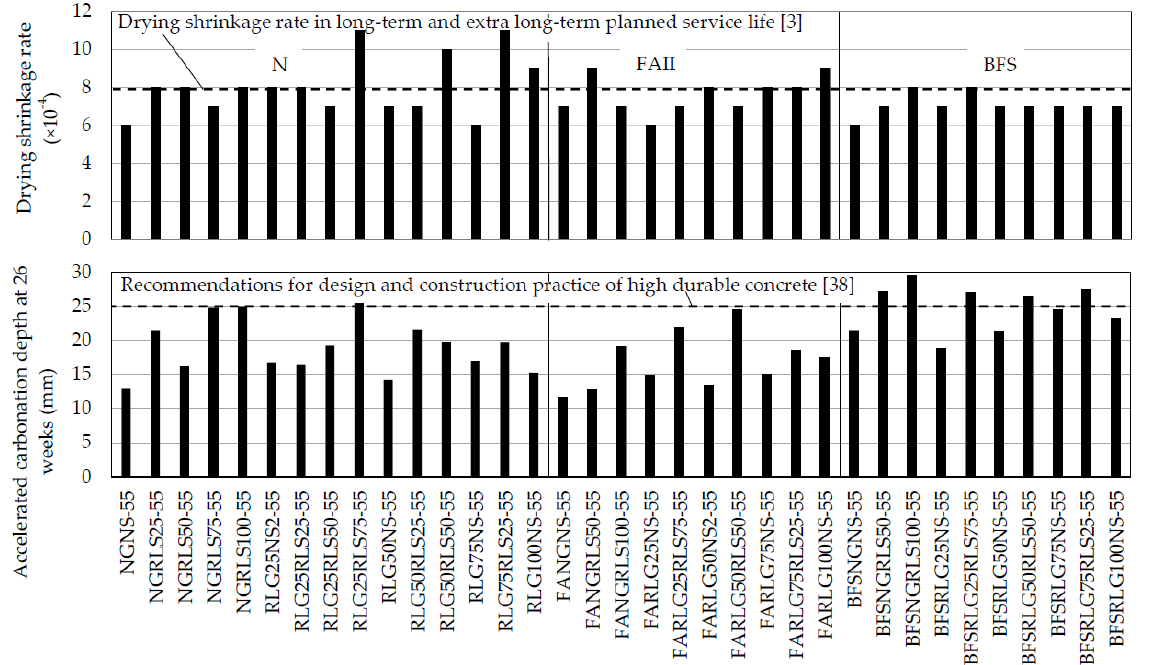
Figure 7. Drying shrinkage rate and accelerated carbonation depth of concrete with recommendations for design and construction practice of high durable concrete [38].